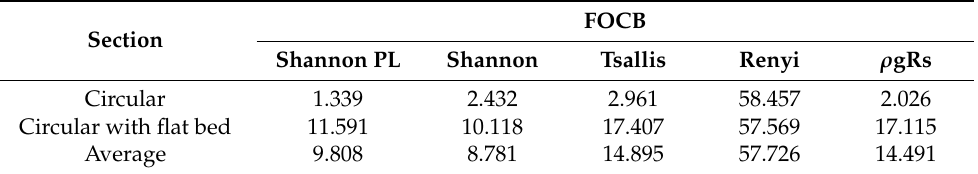
Table 4. The values of FOCB in circular and circular flat bed channels for all entropy models to predicting shear stress